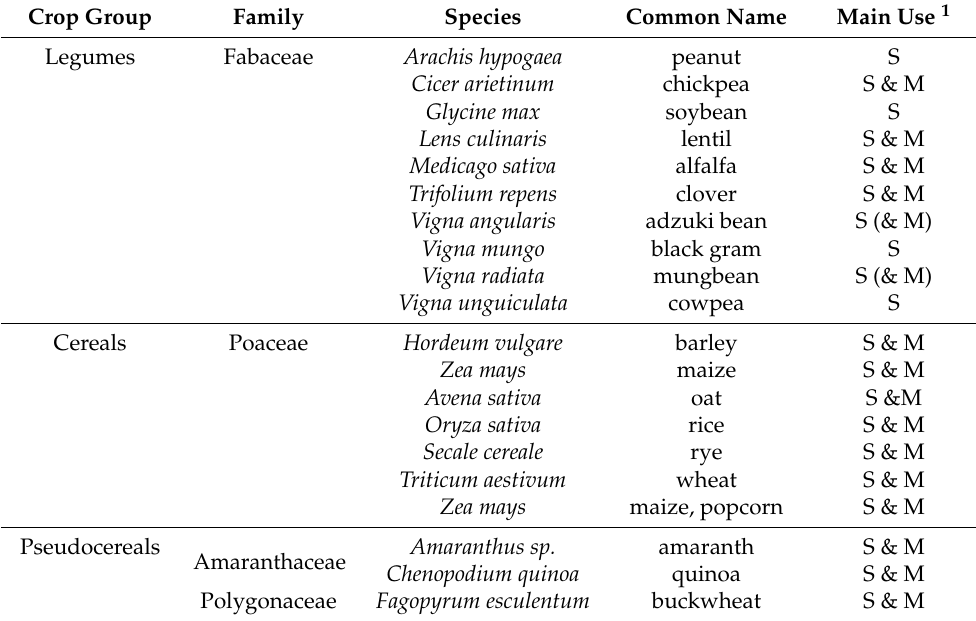
Table 1. The crop groups commonly used for sprouting and microgreen